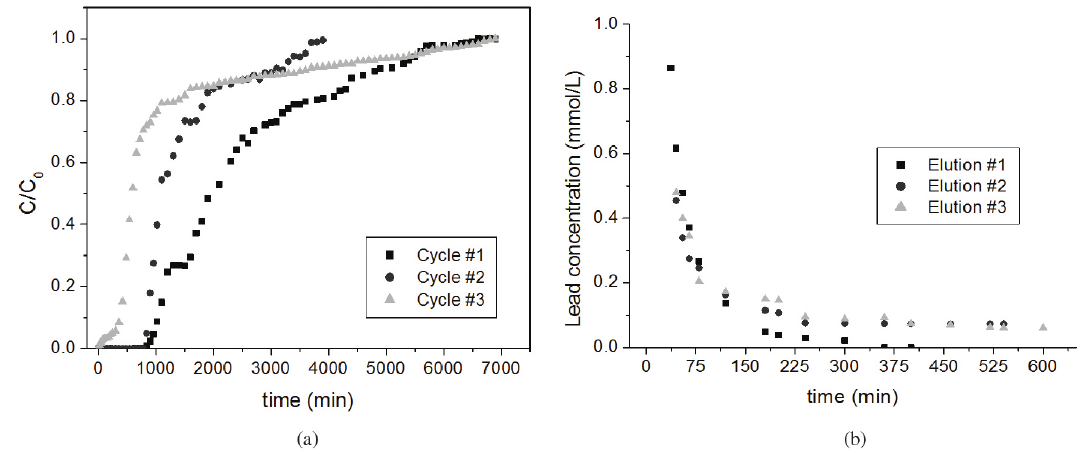
Figure 3. (a) Adsorption and (b) desorption curves for the system of Pb 2+ /calcined Fluidgel (flow = 1 mL/min., particle size = 0.855 mm, C = 0.36 mmol/L). 0 Table 3. Parameters of breakthrough curves for the removal of lead in adsorption/desorption cycles using CaCl System